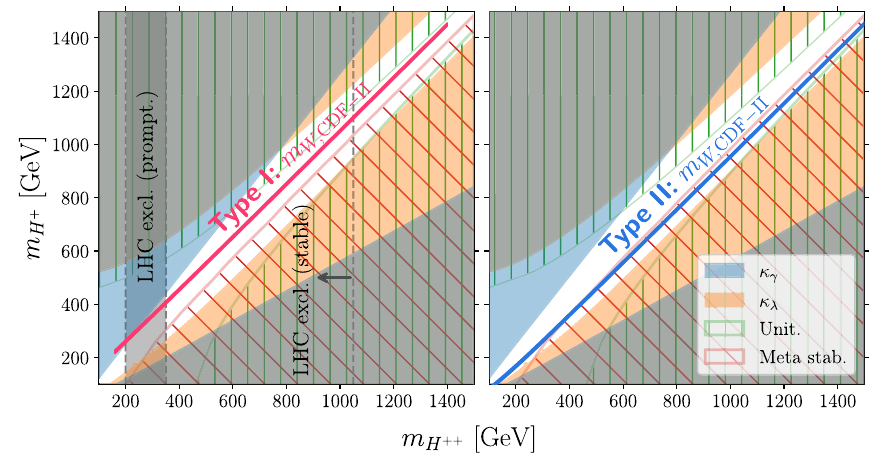
Fig. 4 Constraints on ( m H ++ , m H + ) parameter space for the HTM from the measurement of Higgs-photon coupling ( κ γ , blue shaded region), Higgs self-coupling ( κ λ , orange shaded region), perturbative unitarity(greenhatchedregion),andmeta-stabilityconditionofthevac- uum (red hatched region). We set λ 4 = 0 and λ (cid:4) = 1 for all panels. The left(right)columnshows the2 σ favored parameterspacethatexplained the measured m W by CDF-II for the type-I (-II) model as red (blue) nar-